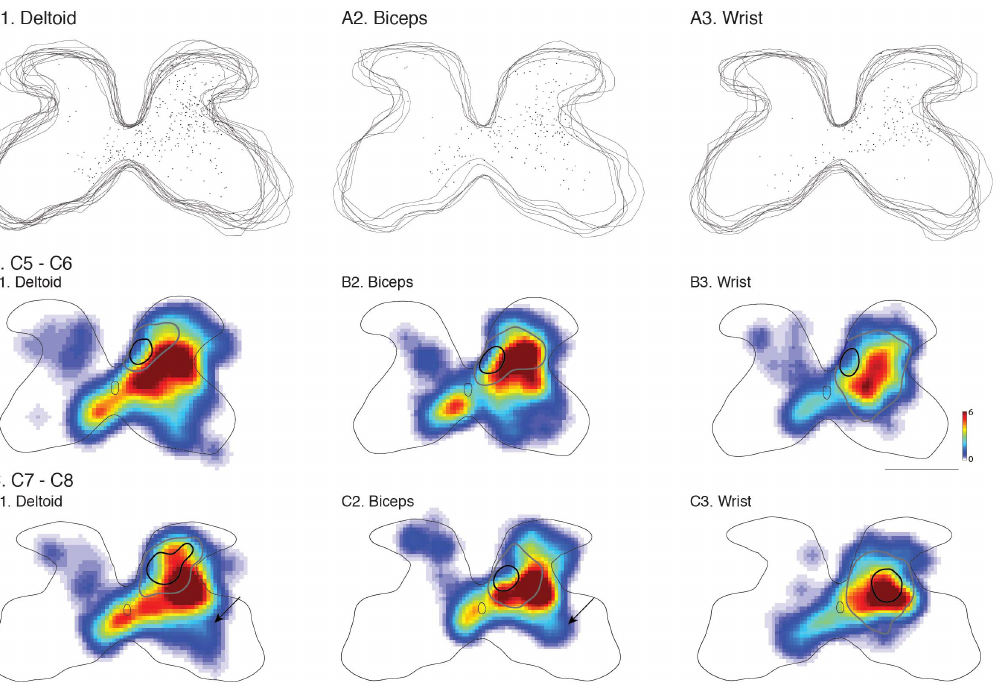
Figure 8. Segmental locations of last-order interneurons after PRV injections into individual muscle groups and CST-interneuron topographic relationship. (A1–A3) Overlaid C7–C8 section images processed in Neurolucida showing positions of individual last-order interneurons from PRV injected into the deltoids, biceps and the wrist extensor compartments in representative animals. B1–B3. Density heat map produced from all labeled sections at cervical levels C5–C6. C1–C3. Density heat map produced from all labeled sections at cervical levels C7–C8. Overlaid onto heat maps are shoulder, elbow and wrist high-density (black) and low-density (gray) CST termination contours. Color scale represents cells per mm 2 . Size bar=500 m m.